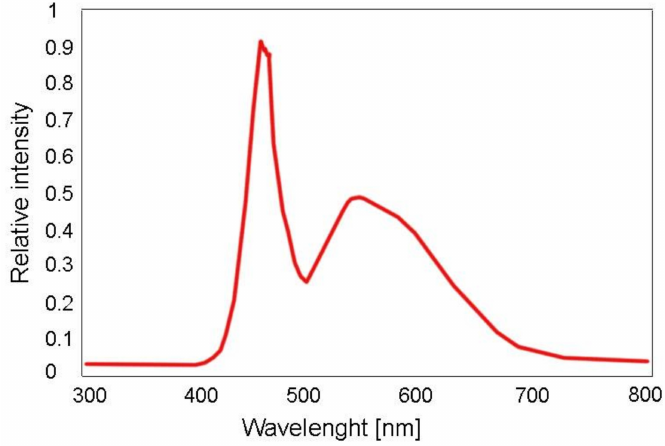
Figure 4. Emission spectrum of a commercial white light LED of GaN, InGaN and Ce:YAG kind for the reversible colorization of photochromic textures of this work, adapted from [30].